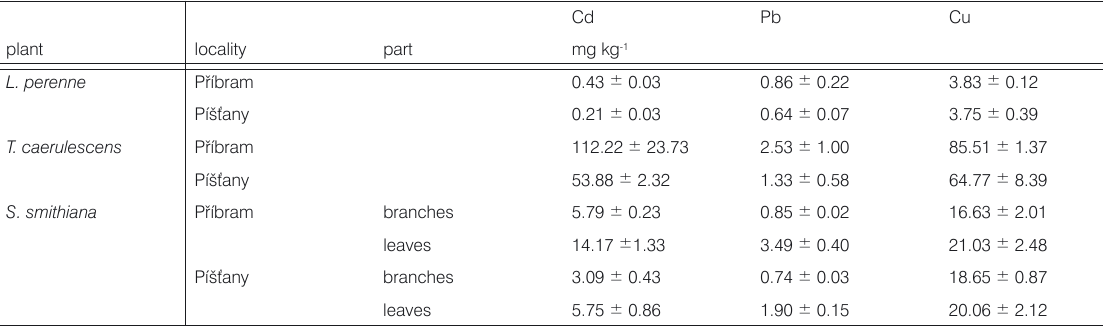
Table 4. Content of heavy metals in plant biomass (mg kg -1